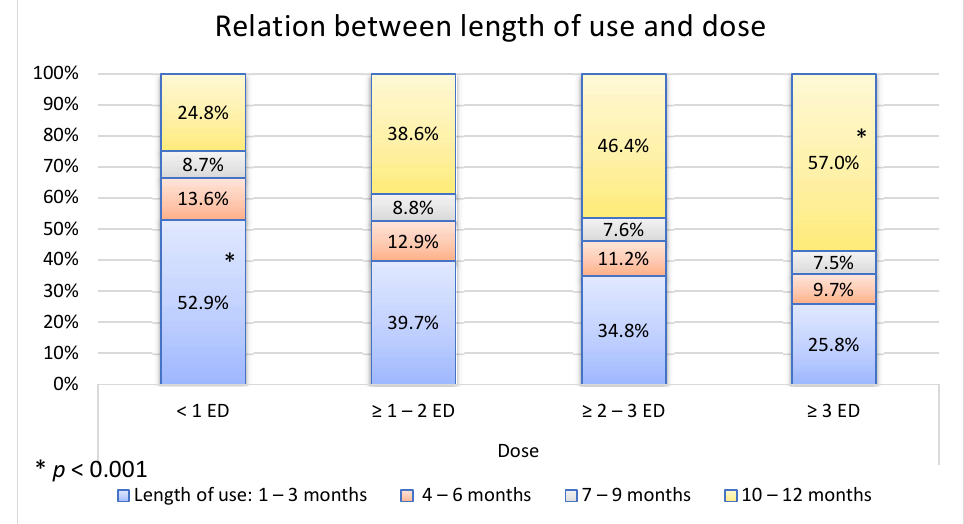
Figure 3. Relation between length of use and dose of benzodiazepines (BZDs).